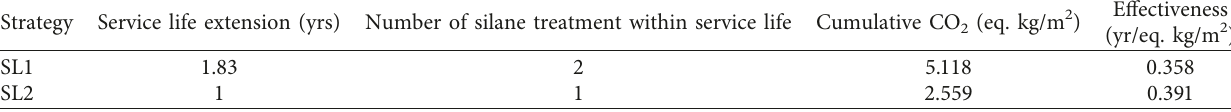
Table 3: Service life extension and CO